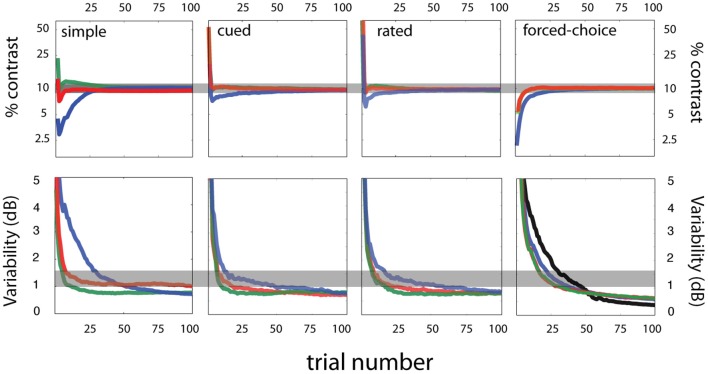
Simulation results. Sensitivity threshold estimates—accuracy and variability. Accuracy (top row) and variability (bottom row) of sensitivity threshold estimates are presented as a function of trial number for four tasks—simple, cued, rated, and forced-choice detection (arranged by column). For each task, three response states (red, blue, green) were simulated for an observer with the same sensitivity parameters (contrast threshold = 10%; contrast exponent = 2; see Figure 10 for more details on the simulated response states). Across the different criterion states simulated for each task, the general willingness to respond is signified by color: conservative (green), intermediate (red), and liberal (blue) response states.